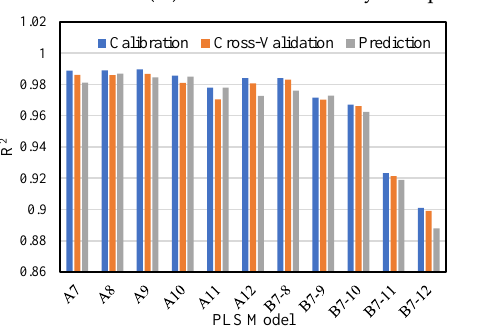
Figure 4. Loading plot of PC1 and PC2 derived from PCA of hyperspectral spectra in VIS – NIR ( A ) and SWIR band ( B ).